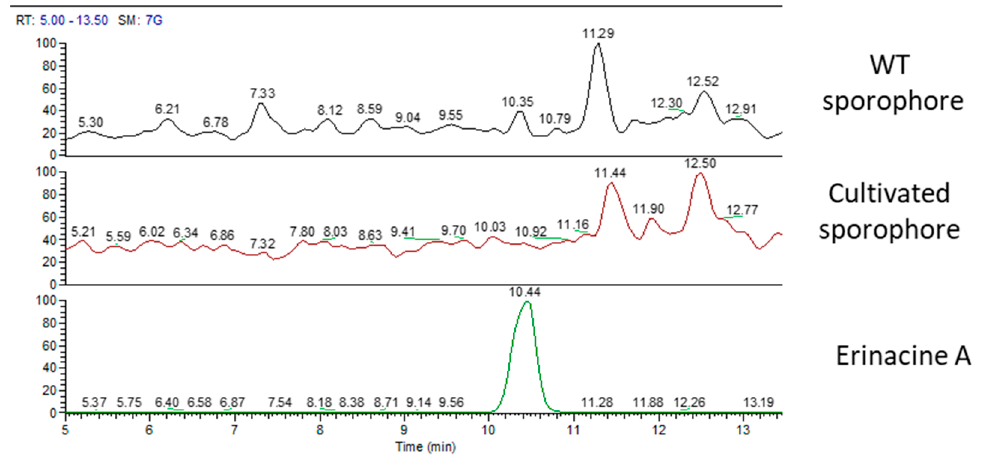
Figure 6. MS traces of wild type sporophore (top), cultivated sporophore (middle), and erinacine A standard molecules (bottom).